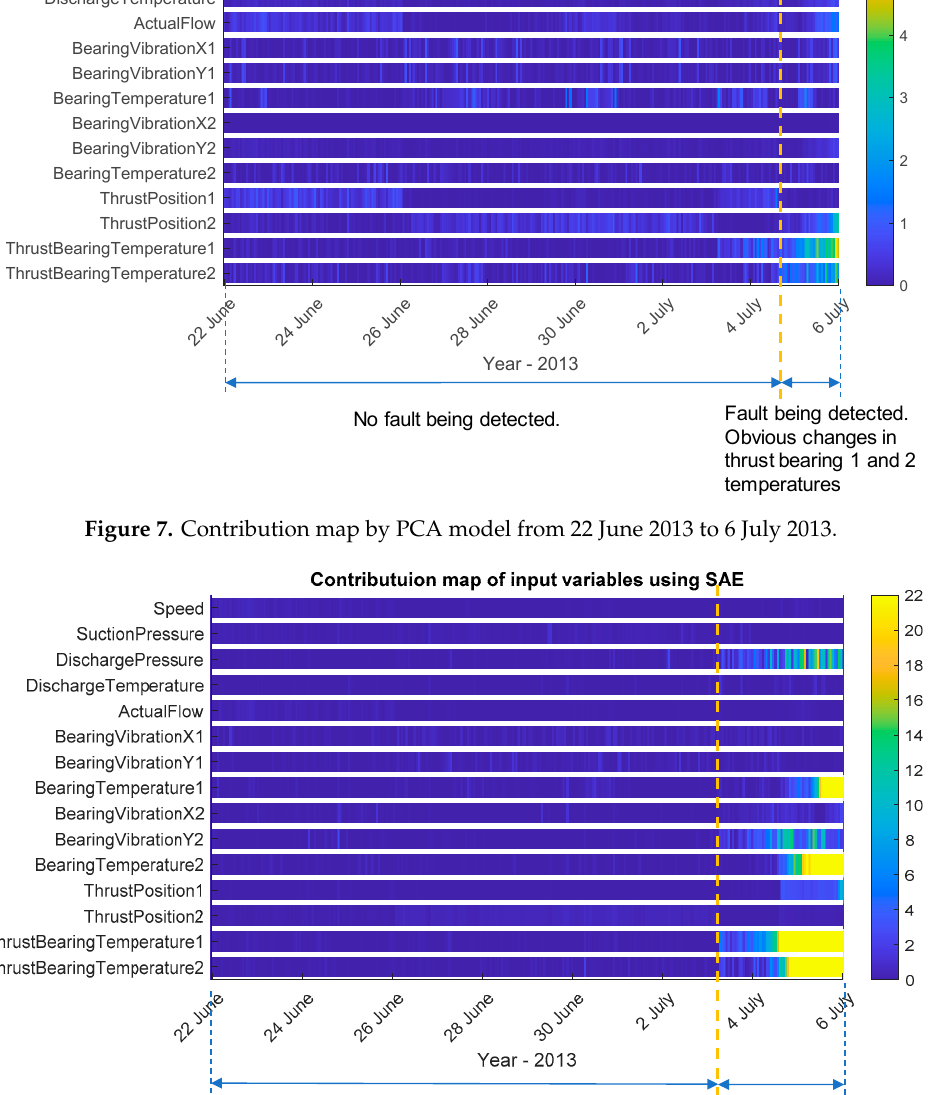
Figure 8. Contribution map by SAE model from 22 June 2013 to 6 July 2013.